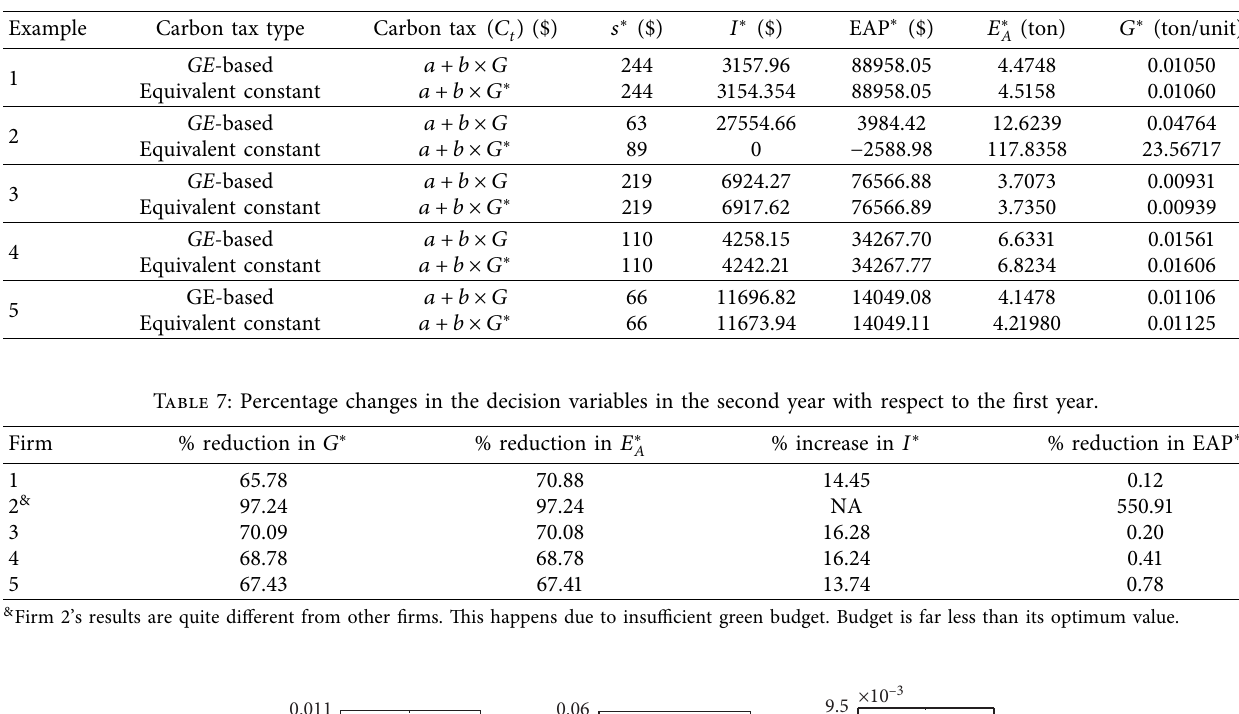
Table 6: Comparison of GE -based carbon tax and equivalent constant carbon tax.